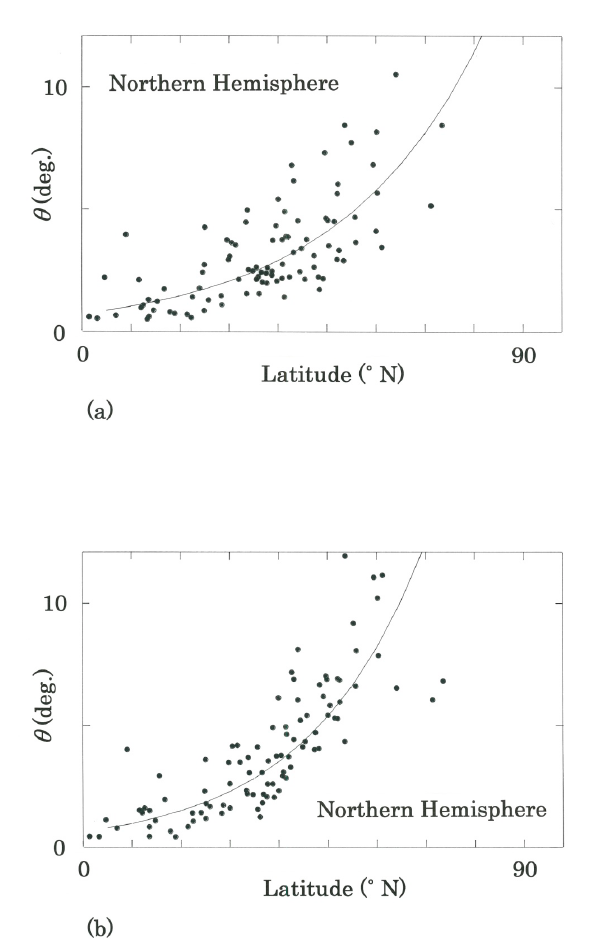
Figure 2. Rotation angles between the monthly distributions of temperatures on the 97 Northern ‐ Hemispheric stations versus their latitudes. ( a ) Rotation is considered from Period I (1931 ‐ 1960) to Period II (1951 ‐ 1980). The curve superimposed in the plots represents the optimal exponential regression ( r = 0.738 with d = 1.788 > d U = 1.55 for n = 97). Note that the Urumchi’s angle θ = 17.80° on the top in Table 1 is truncated. ( b ) Rotation from Period II (1951 ‐ 1980) to Period III